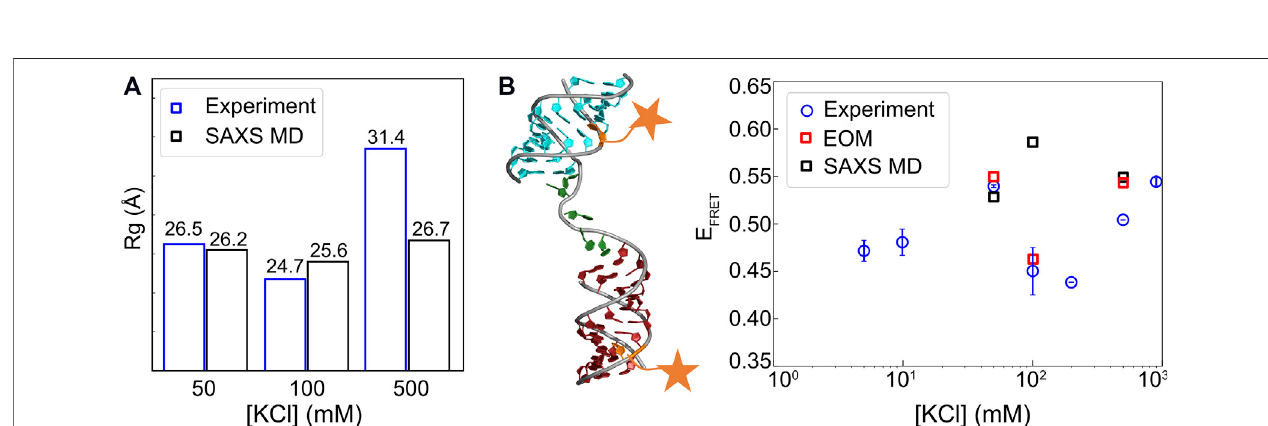
FIGURE 11 | Spherical heat maps monitoring the occupancy of conformations visited by the HJH RNA. The conformations are monitored by two angles (bending andtwisting)indifferentsaltconditions (A) 50 mM, (B) 100 mM,and (C) 500 mMKCl.Therepresentativestructures (D – F) foreachsaltcondition.Eachframerepresents a cluster center; the most populated cluster is colored in